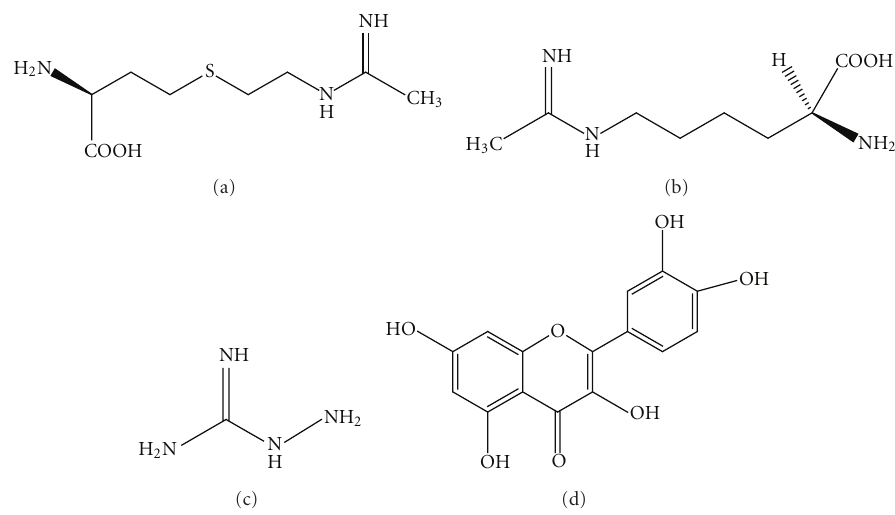
Figure 4: Chemical structure of GW274150 (a), L-NIL (b), aminoguanidine (c), and quercetin